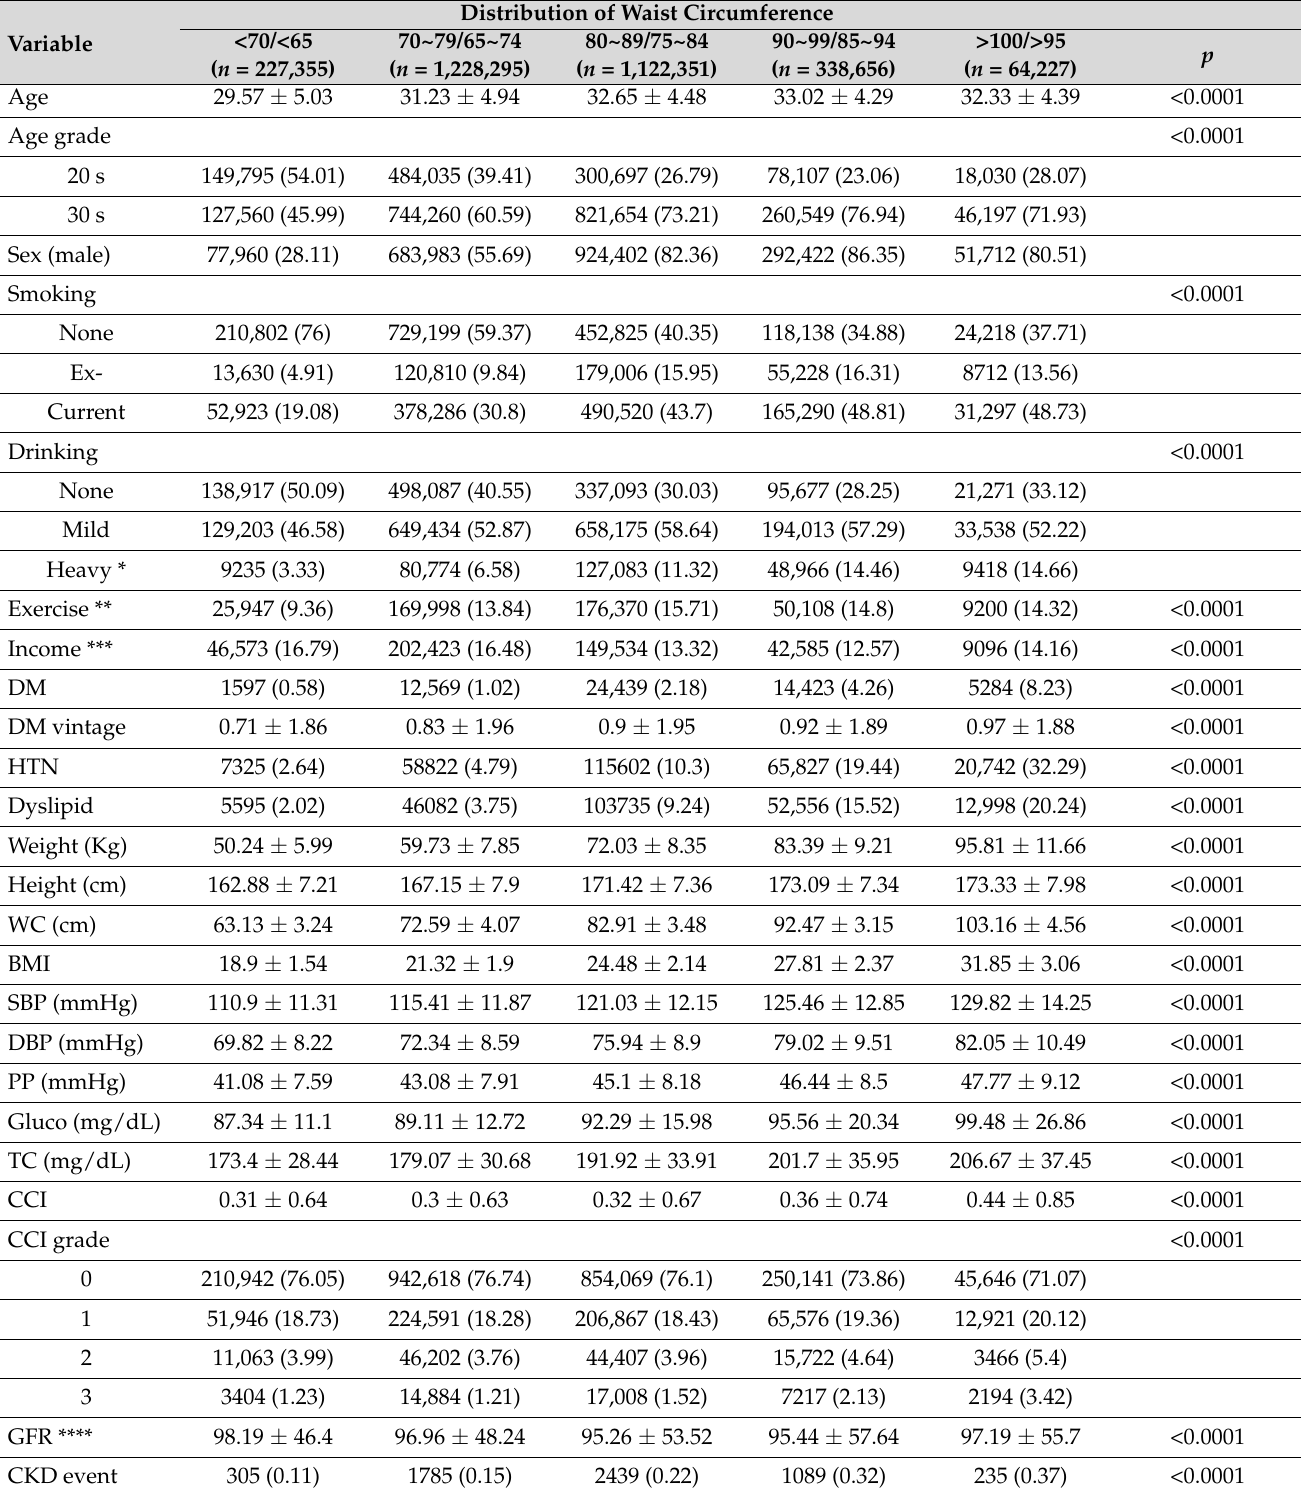
Table 3. Baseline characteristics of participants by level of waist circumference. Distribution of Waist